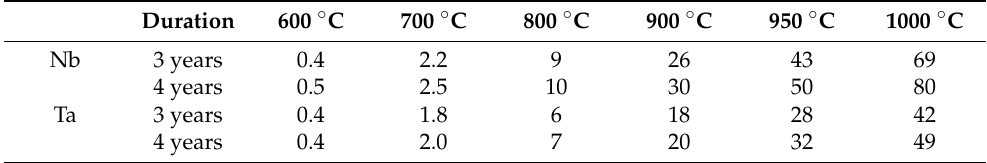
Table 8. Thickness extrapolation ( µ m) of the interaction layer on the outer side of the sandwich cladding as a function of time and